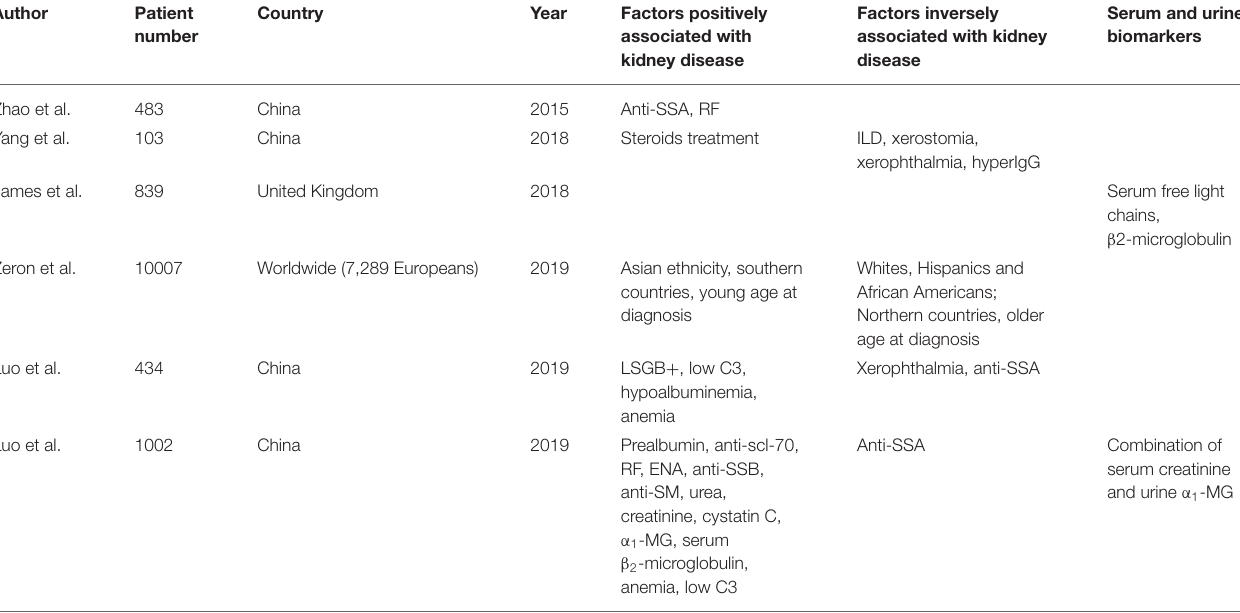
TABLE 1 | Summary of most relevant findings from recent studies on kidney disease in